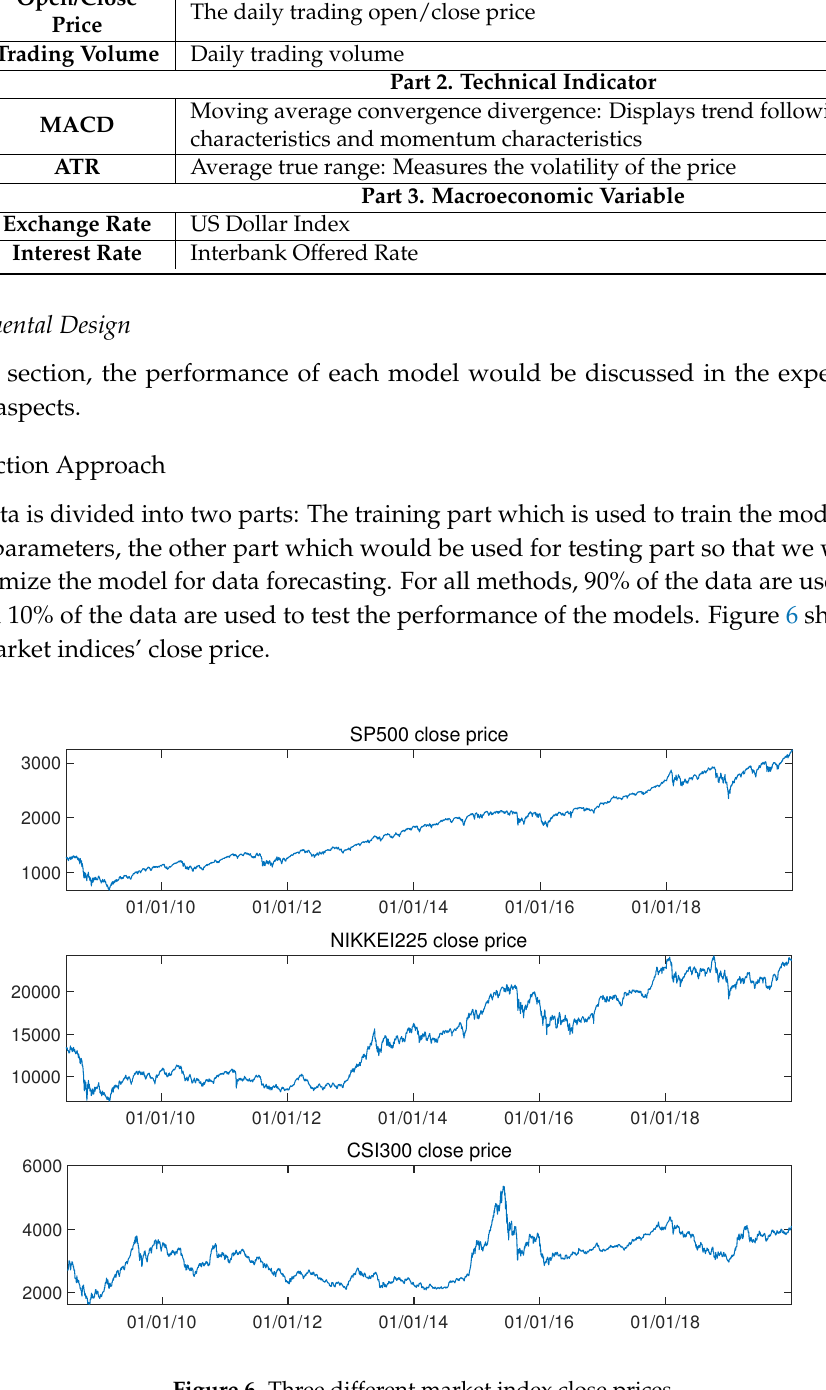
Figure 6. Three different market index close